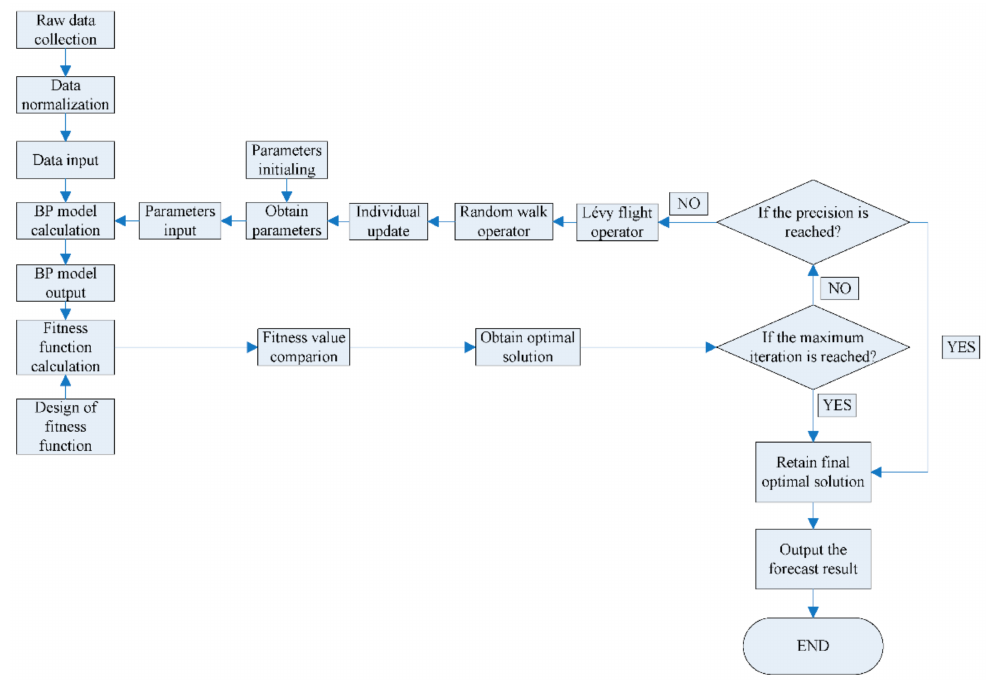
Figure 1. The flow chart of back propagation neural network that is optimized by the Cuckoo Search algorithm (CS-BP)